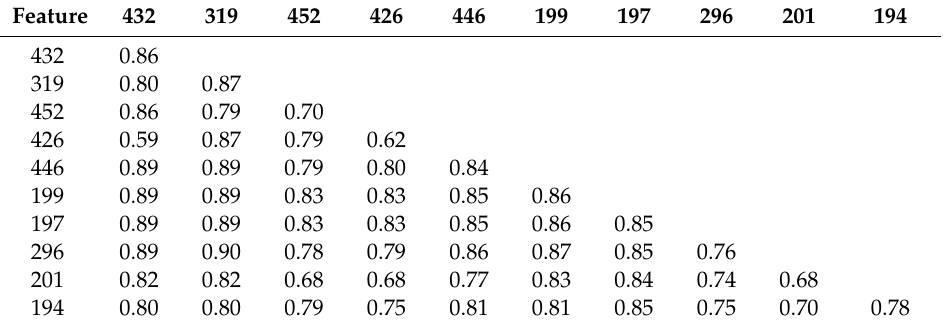
Table 11. E ff ect of selected features for level